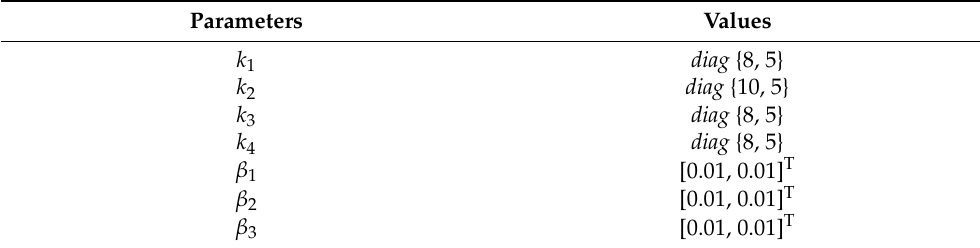
Table 2. Parameters of proposed backstepping controller.